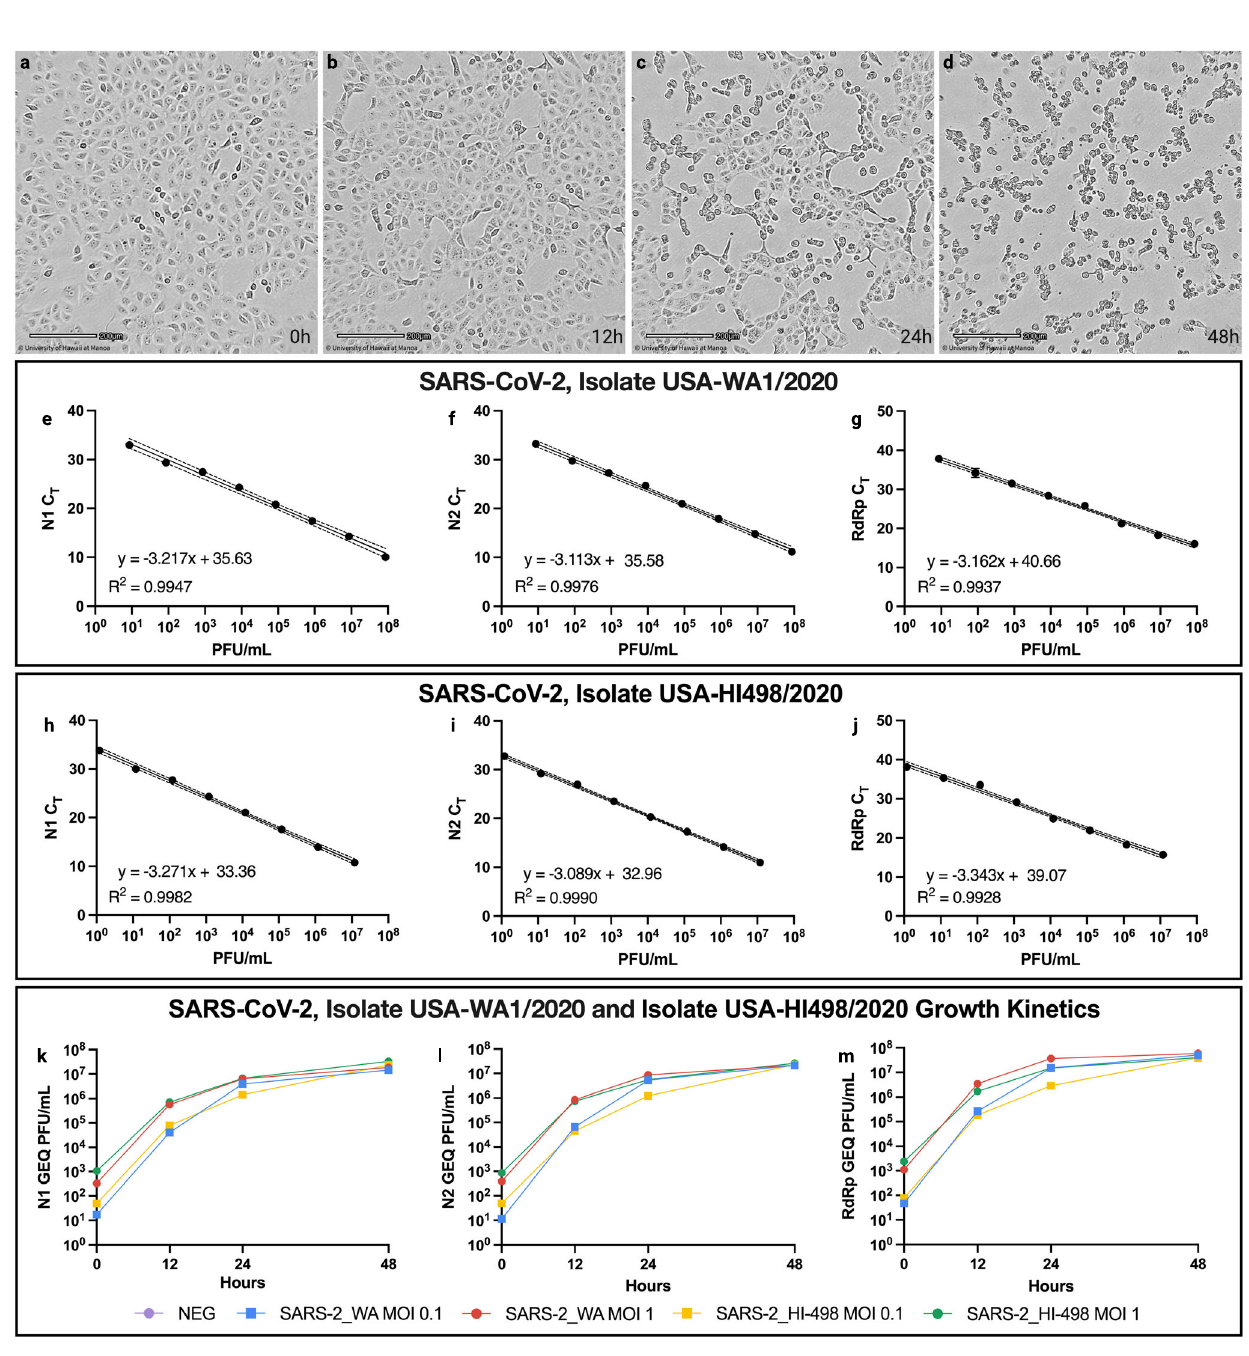
Fig. 1 Cytopathic Effect and Growth Kinetics of SARS-CoV-2, Isolate USA-HI498 2020. The fi gure shows time-lapse cell images of VeroE6 cells infected with SARS-CoV-2 isolate USA-HI498 2020 at different time points, demonstrating the cytopathic effect (CPE) induced by the virus at multiplicity of infection (MOI) 1. a 0 h, b 12 h, c 24 h, and d 48 h. Scale bar equals 200 µ m. e Genomic equivalent (GEQ) of SARS-CoV-2, isolate USA-WA-1/2020 with N1 primers. f GEQ of SARS-CoV-2, isolate USA-WA-1/2020 with N2 primers. g GEQ of SARS-CoV-2, isolate USA-WA-1/2020 with RdRp primers. h GEQ of SARS-CoV-2, isolate USA-HI498/2020 with N1 primers. i GEQ of SARS-CoV-2, isolate USA-HI498/2020 with N2 primers. j GEQ of SARS-CoV-2, isolate USA-HI498/2020 with RdRp primers. k Growth kinetics of SARS-CoV-2 isolates USA-HI498/2020 and USA-WA-1/2020 at multiplicity of infection (MOI) 1 and 0.1 over 48 h using the N1 GEQ (e and h). l Growth kinetics of SARS-CoV-2 isolates USA-HI498/2020 (yellow and green) and USA- WA-1/2020 (blue and red) at MOI 1 and 0.1 over 48 h using the N2 GEQ ( f and i ). m Growth kinetics of SARS-CoV-2 isolates USA-HI498/2020 and USA- WA-1/2020 at MOI 1 and 0.1 over 48 h using the RdRp GEQ ( g and j